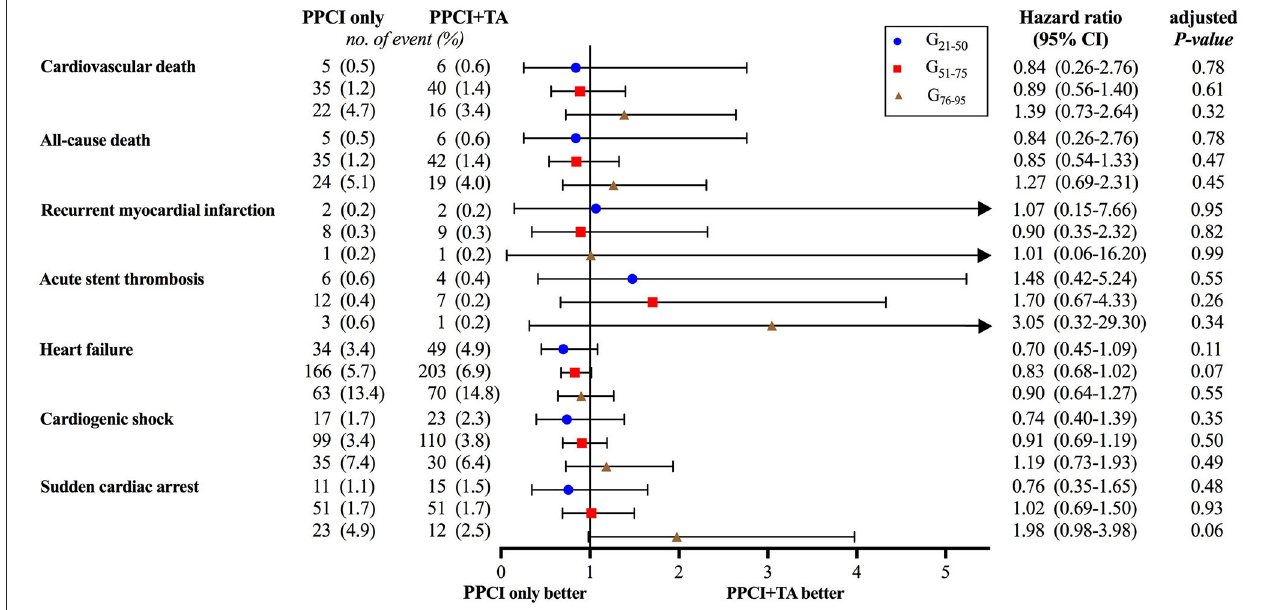
FIGURE 5 | The incidence of in-hospital stroke. There was no significant difference in the risk of in-hospital stroke between the two treatment groups in all age subgroups.